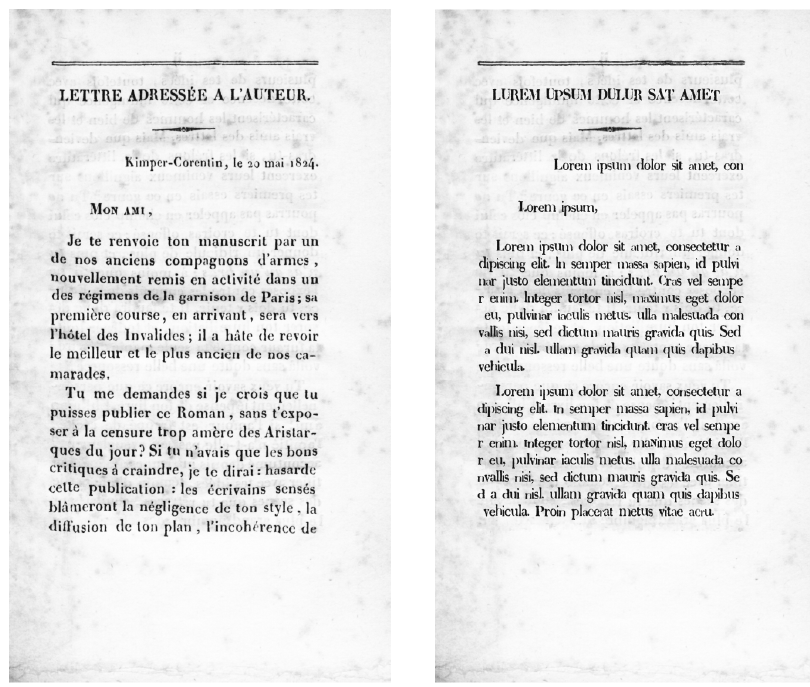
Figure 2. Synthetic document image generation. ( Left ) original document image. ( Right ) synthetic document image generated automatically with the random text “Lorem ipsum”. The automatically generated image looks similar to the original one. The result is still perfectible. Here, as the original image suffers from local deformations, the characters extracted to build the font are quite different and may look too random when assembled on the synthetic document. A better font extraction or composition using the context to choose new characters may alleviate this